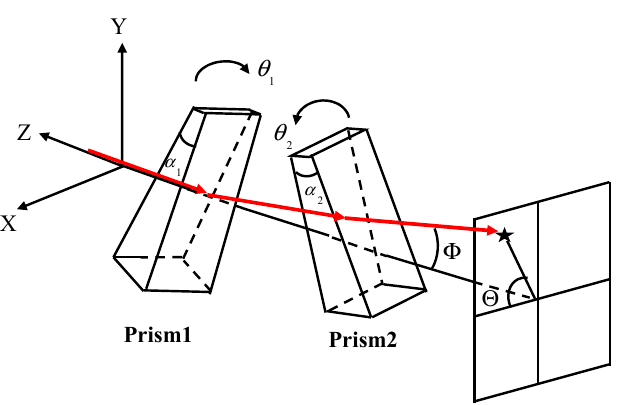
α α and are the apex angles of prism1 and prism2, 1 2 Θ is the azimuth angle, and Φ is the